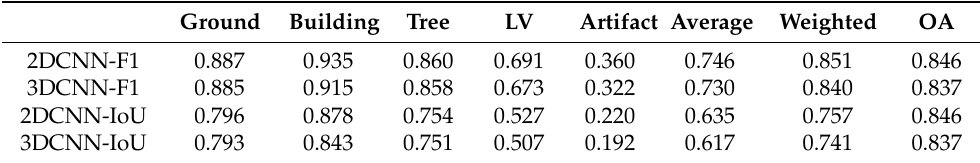
Table 9. Average and weighted F1 and IoU scores for 2DCNN and 3DCNN classifiers for the LASDU dataset. The OA is also reported.